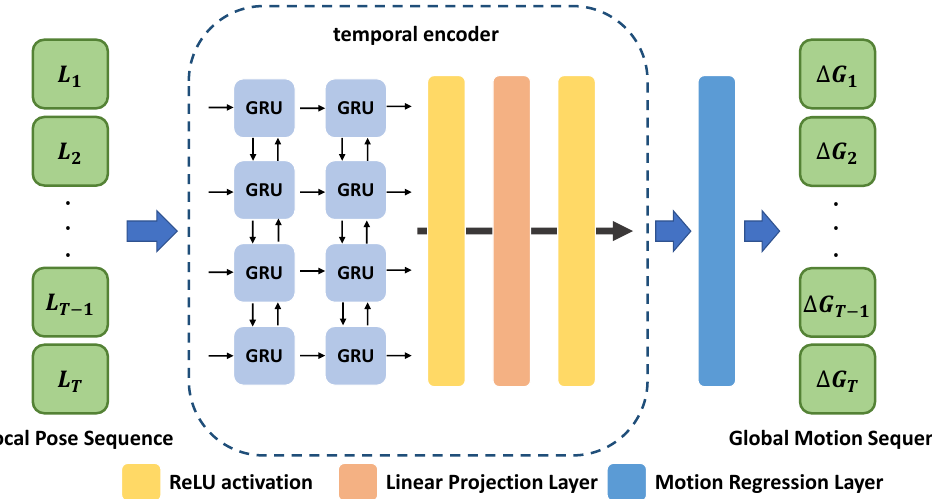
Figure 4. Architecture of G lobal M otion R egressor